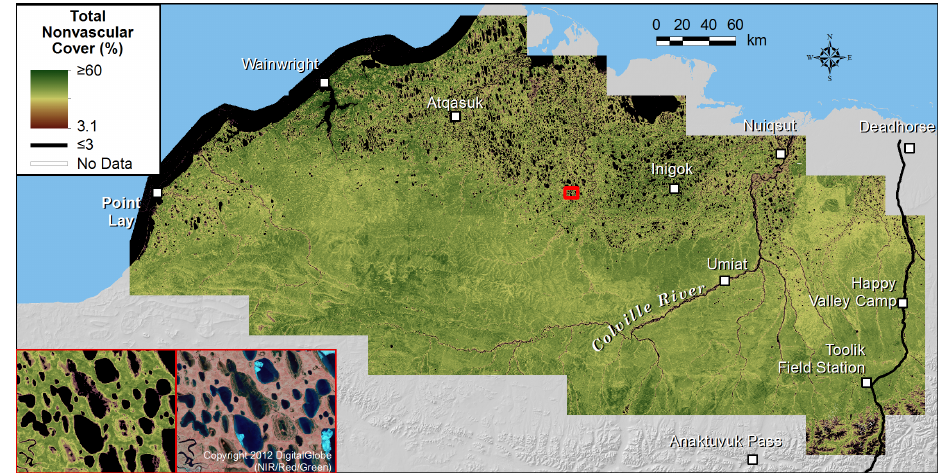
Figure 9. Map of total nonvascular cover based on the random forest model with 78 predictors, North Slope, Alaska. The inset map portrays a typical lake-rich portion of the coastal plain; total nonvascular cover is generally high except in flooded lake margins and drained lake basins.